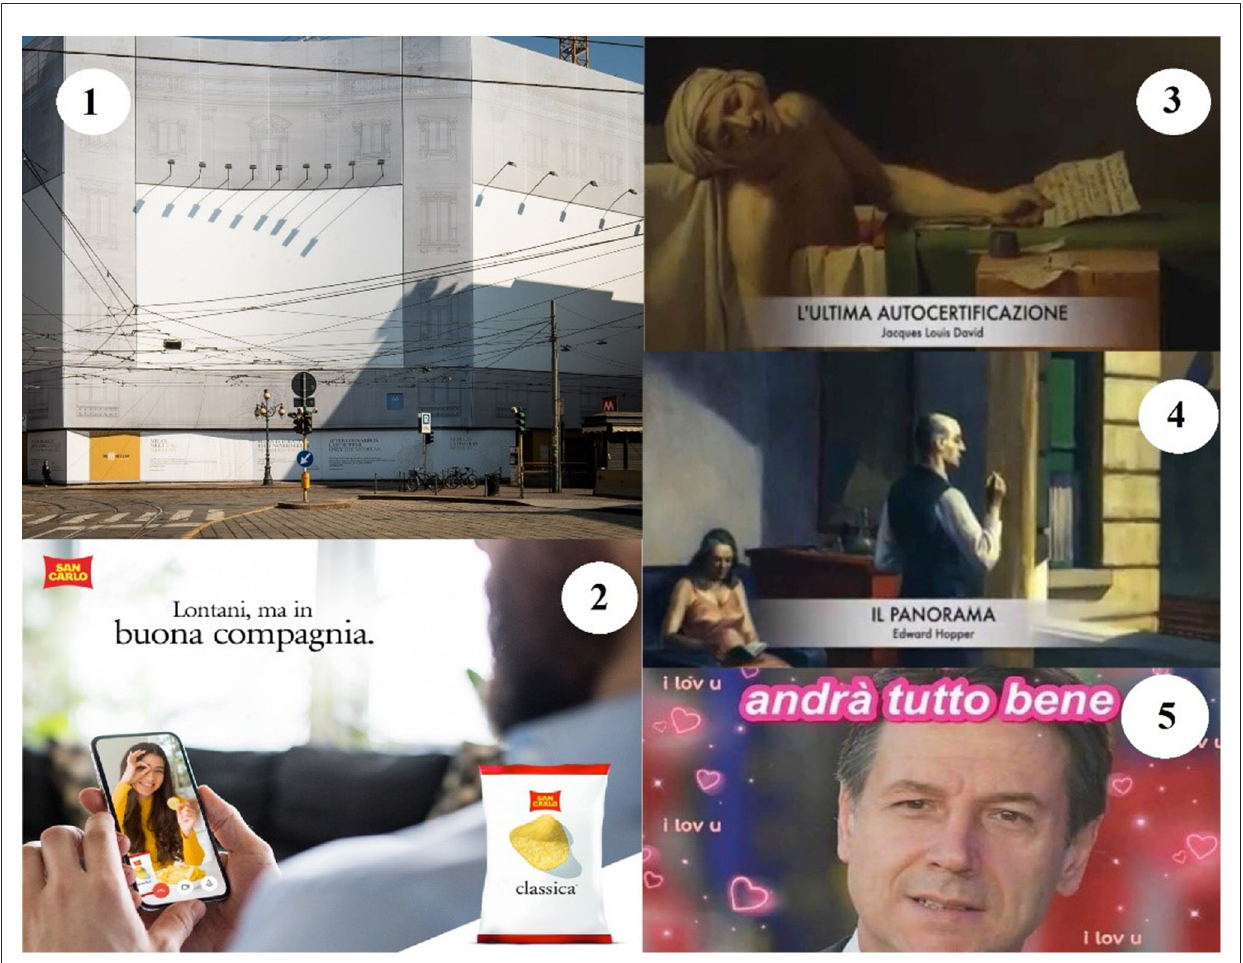
FIGURE1 Photo 1—white billboards in Milan; Photo 2—San Carlo advertising with a pun; Photo 3—meme related to self-certification; Photo 4—meme linked to the visible panorama during isolation; Photo 5—meme inspired by Prime Minister Giuseppe